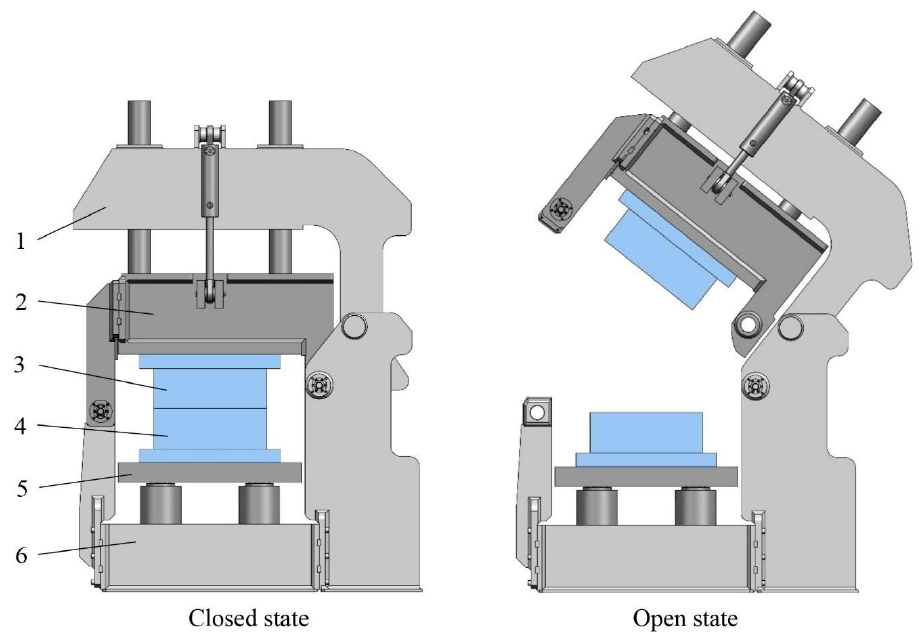
Figure 2. Shuttle mold carrier and a mounted T-RTM mold (KraussMaffei) (1—upper frame; 2—upper plate; 3—the upper half of the T-RTM mold; 4—the bottom half of the T-RTM mold; 5—lower plate; 6—lower frame).